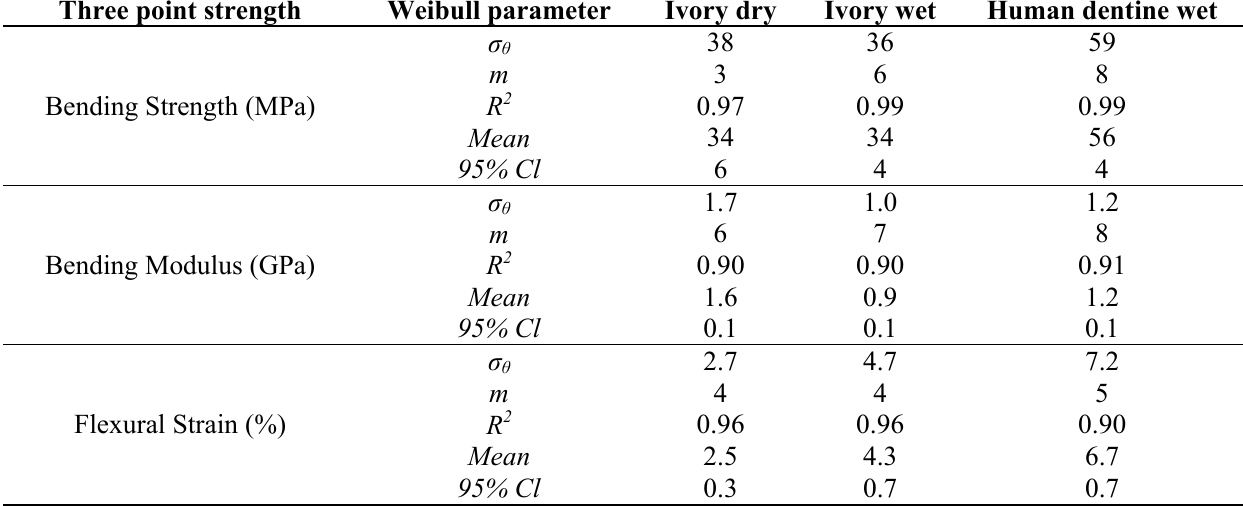
Table 1. Weibull scale σ θ and shape m parameters obtained upon fitting Equation (6) to three point strength, modulus, and flexural strain